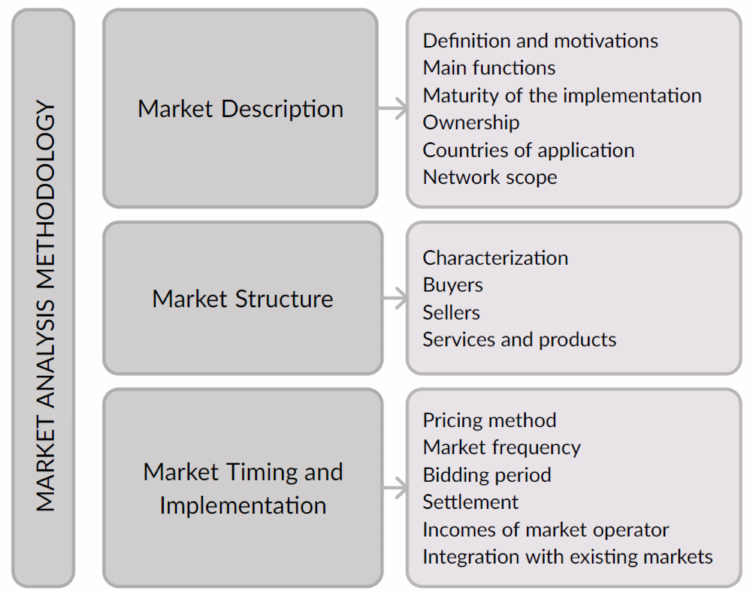
Figure 2. Market analysis